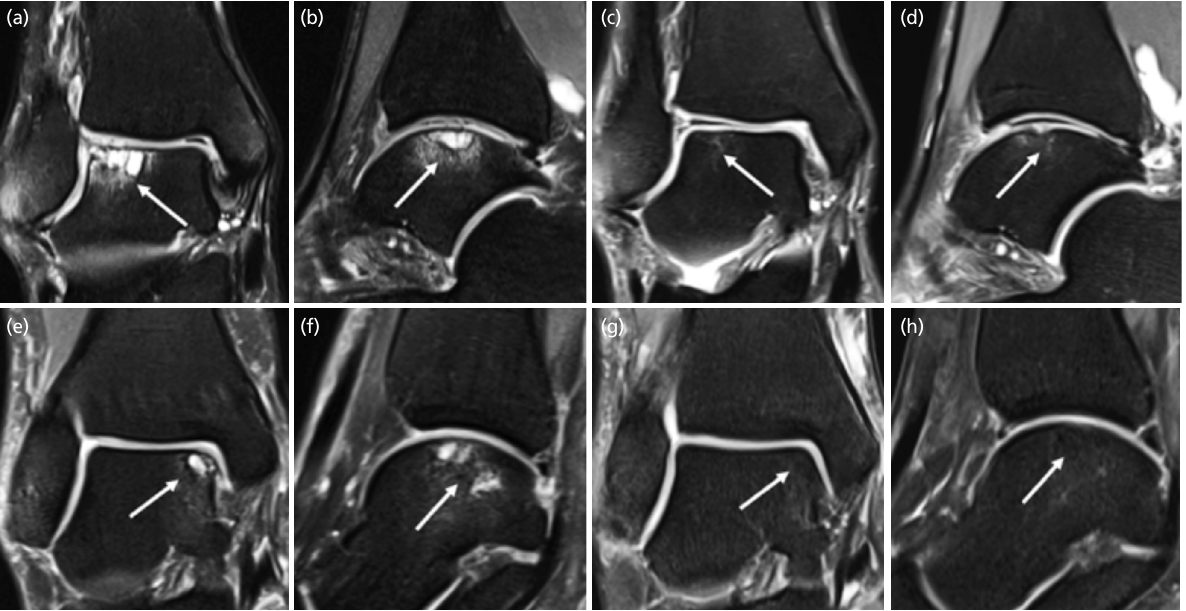
Fig. 2: (a) Coronal and (b) sagittal MR images of the second case showing right ankle osteochondral lesion at the lateral aspect of the talar dome (white arrows). Corresponding images at 2 years, (c) and (d) showing osteochondral regeneration and integration (white arrows). MR images of the third case with coronal (e) and (f) sagittal views of the right ankle showing osteochondral lesion at the medial aspect of the talar dome (white arrows). Corresponding images at 2 years, (g) and (h) showing satisfactory healing. These are all fat-suppressed proton density-weighted MR images.